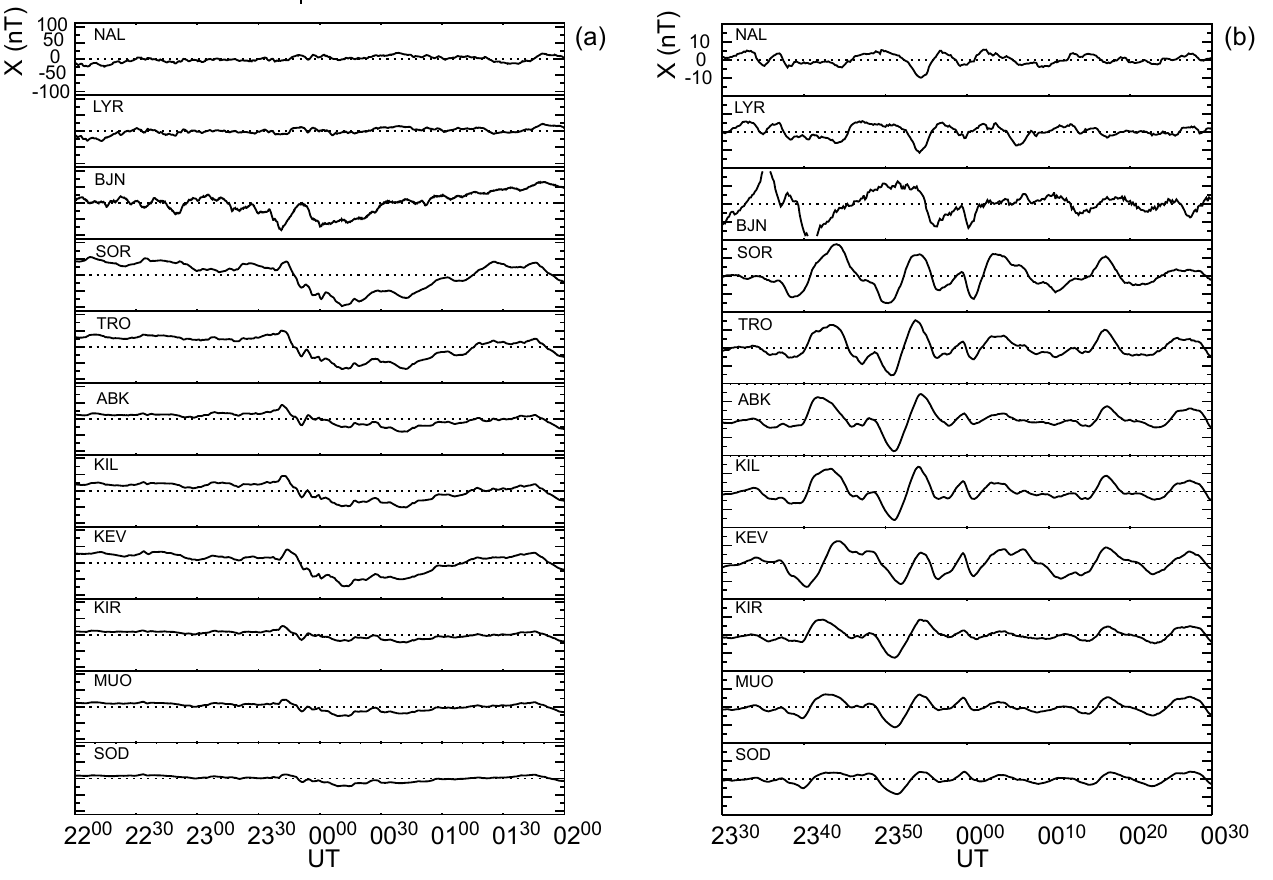
Fig. 3. IMAGE X-component magnetometer data during the substorm interval. (a) unfiltered data between 22:00UT and 02:00UT (b) data bandpass filtered between 1000–20s for the interval